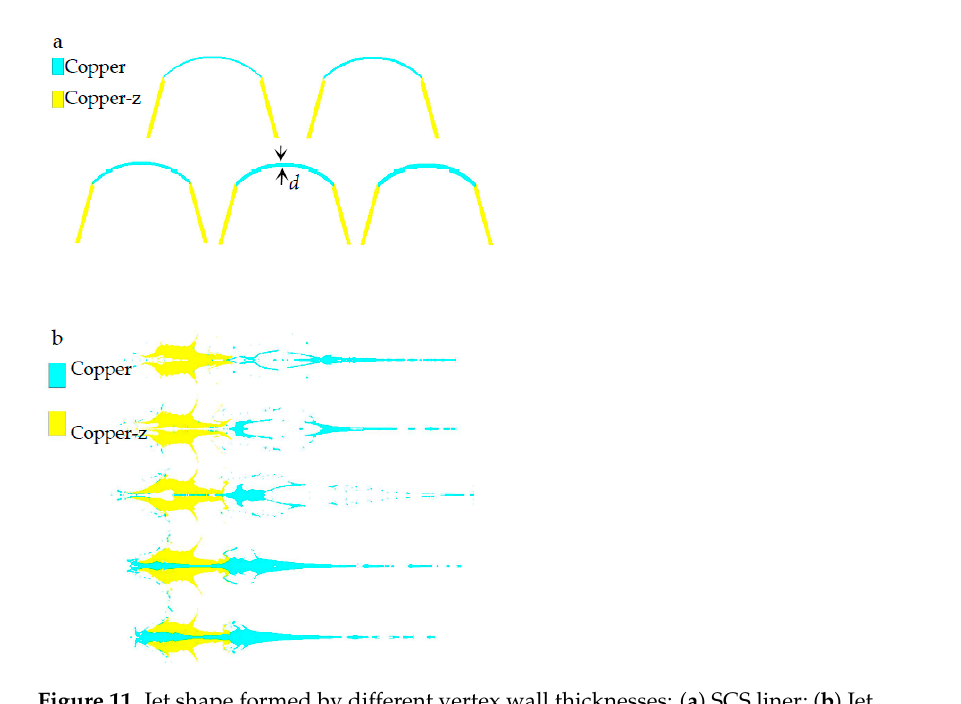
Figure 13. Jets formed by SCS liner with different inner surface bus radius. 3.6. Influence of Truncated Cone Shape on Jet Formation As a part of the SCS liner, the truncated cone affects the forming of the SCS liner. According to the research conclusions in Sections 5.1–5.4, the forming laws of different truncated cones are studied with a wall thickness of the constraint cylinder of 2.4 mm, a top wall thickness of the spherical missing body of d = 2.5 mm, an outer circular bus radius of 45.7 mm, and an inner circular bus radius of 38.7 mm, and the structure of the explosive column and shell remains unchanged. According to literature reports [4,5,15–17], cone- shaped charge liners generally include variable wall thickness (VWT) and equal wall thickness (EWT). Variable wall thickness can be divided into upper thin and lower thick (UTLT) and top thick and bottom thin (TTBT). Figure 14a is a SCS liner with different truncated cones, Figure 14b is the jet shape of the explosive charge. The UTLT jet in Figure 14b changes evenly, and there is a large bulge in the middle of the EWT and TTBT jets.